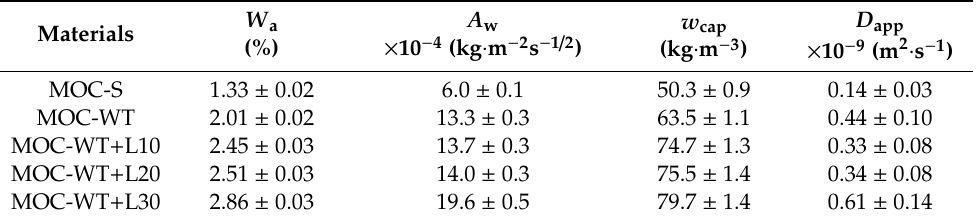
Table 6. Hygric parameters of hardened composites.